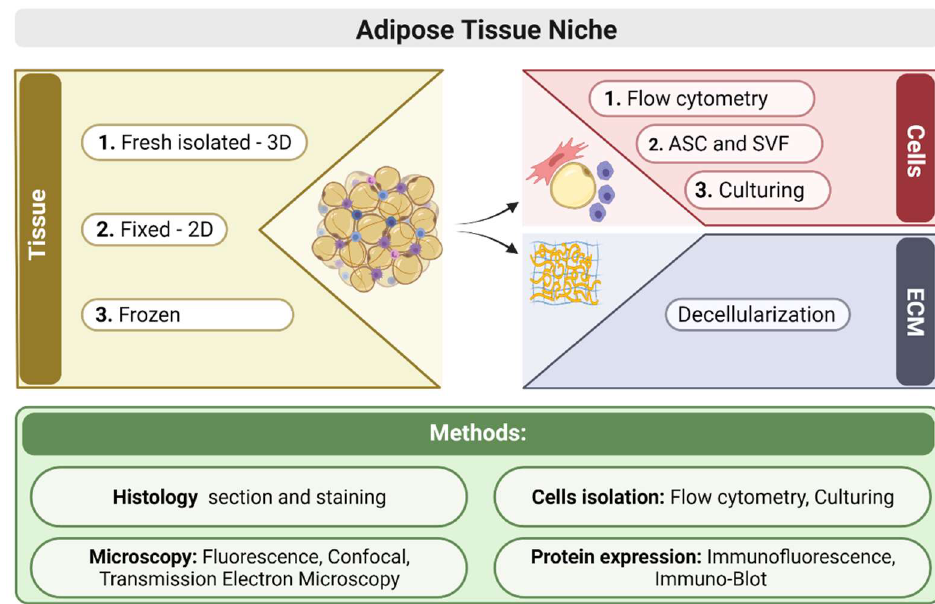
Figure 1. Schematic scheme for methods employed in the study of adipose tissue and